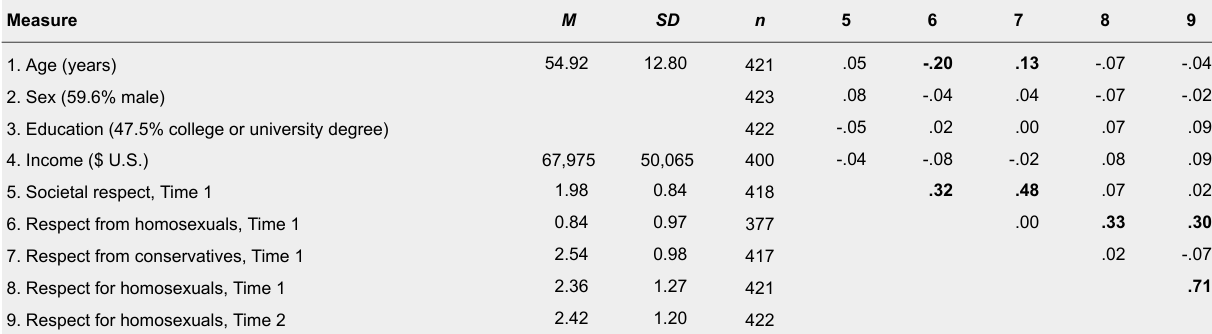
Means, Standard Deviations, and Intercorrelations for Tea Party Supporters in the United States – Study